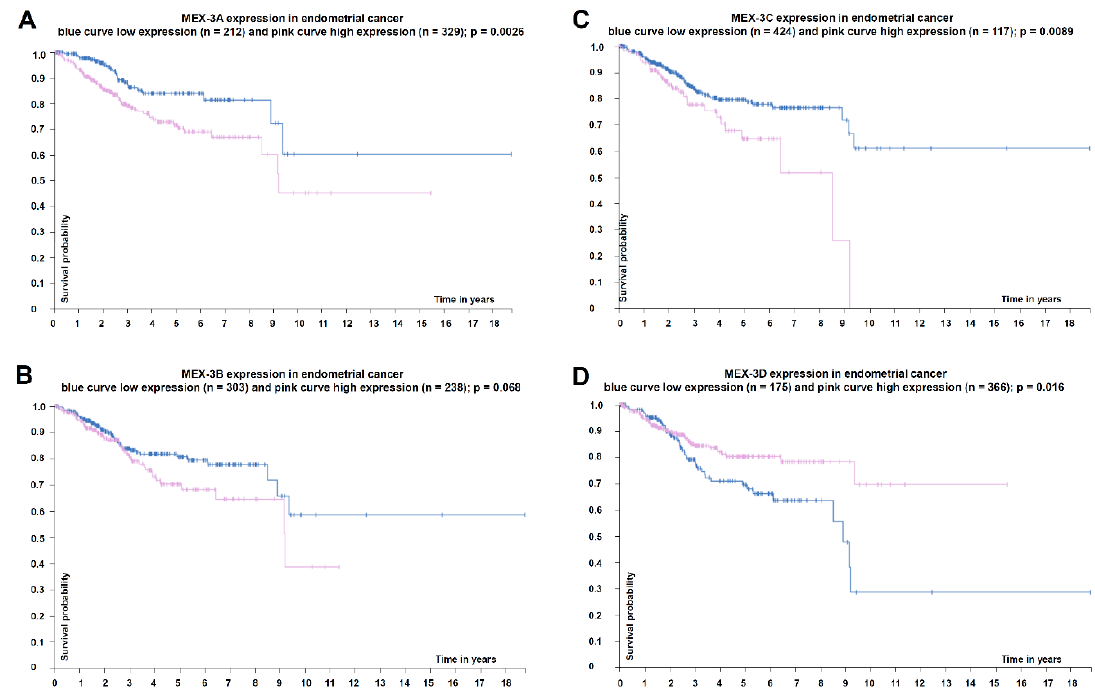
Figure 3. Correlation of the overall survival of endometrial cancer patients’ with MEX-3A–D expression. ( A – D ): Kaplan Meier curves for the overall survival of cancer endometrial patients were generated and correlated to the MEX-3A-D expression levels using The Human Protein Atlas [20–22].